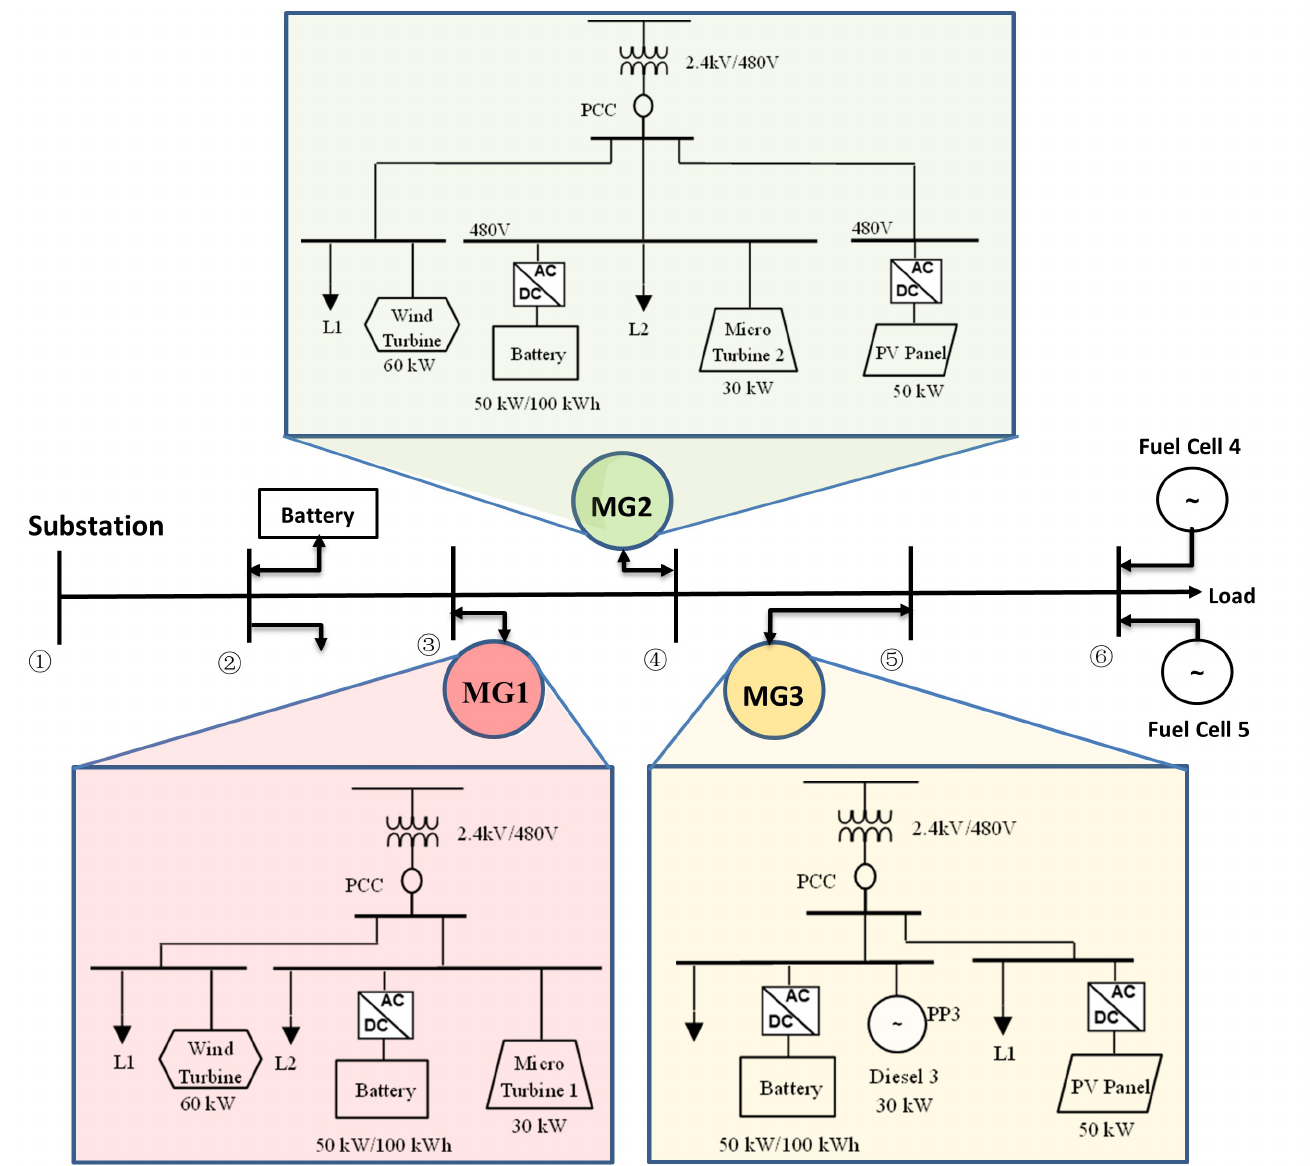
Figure 2. Modified ORNL DECC networked microgrids system.